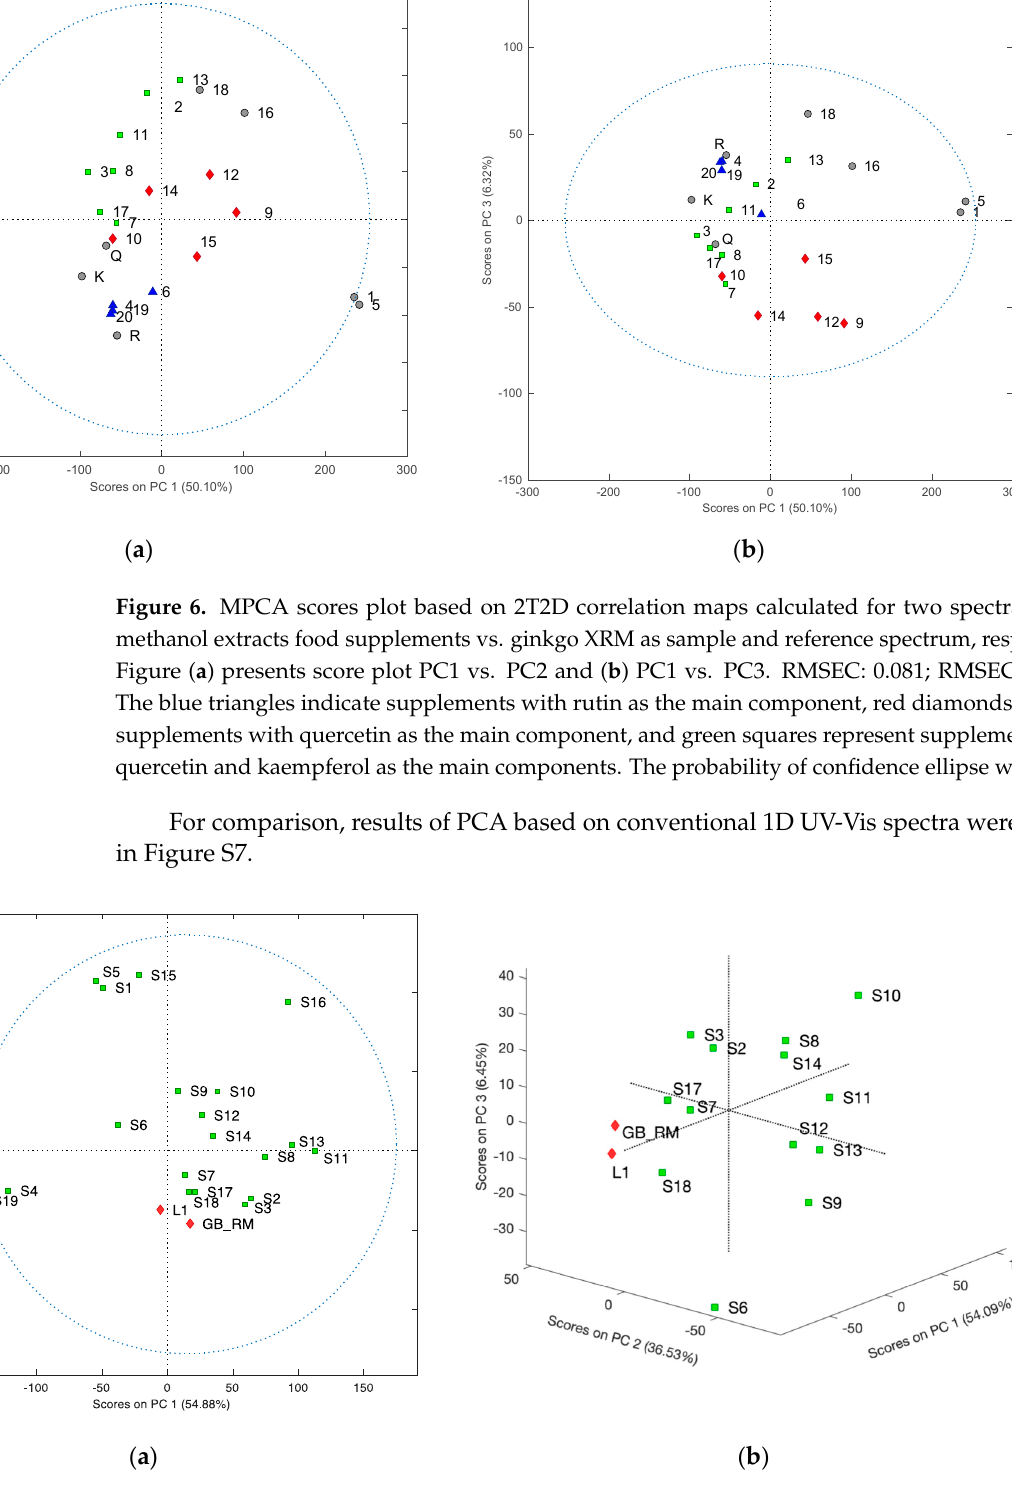
Figure 7. MPCA scores plot base on 2T2D correlation maps calculated for food supplements (sample spectra) vs. averaged spectrum of adulterants: kaempferol, quercetin, and rutin (reference spectrum), RMSEC: 0.066; RMSECV: 0.107; ( a ) plot including all samples; ( b ) MPCA scores plot after excluding samples S1, S4, S5, S15, S16, S19, and S20, RMSEC: 0.140; RMSECV: 0.264.